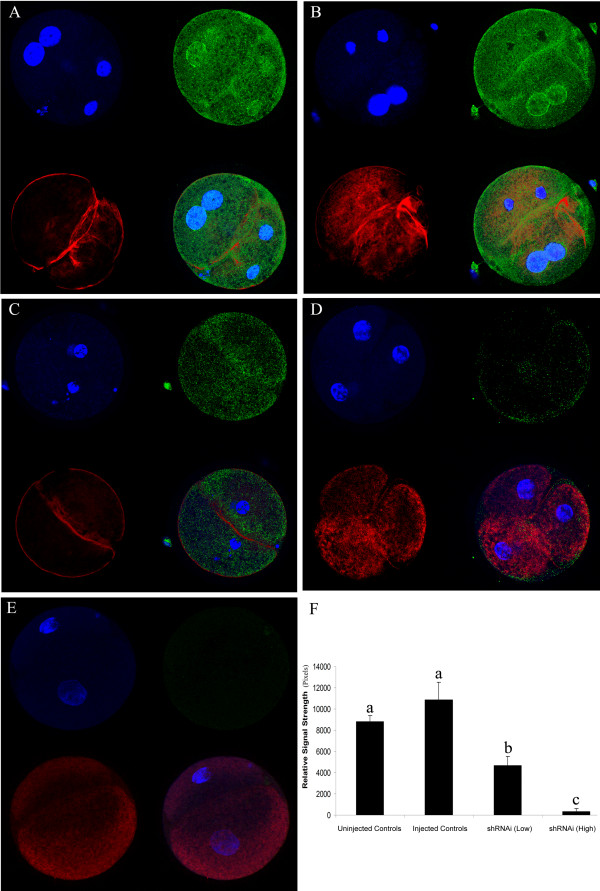
p66Shc protein levels following microinjection of p66 shRNA interfering molecules. The distribution of p66Shc in early bovine embryos was assessed (A, B, C and D). Green, red and blue colors in each representative photomicrograph indicate positive staining for the respective primary antibody: p66Shc (FITC), F-actin (Rhodamine phalloidin), and nuclei (DAPI) respectively. Panels A and B represent Uninjected and Injected (Vehicle) controls respectively. Panel C (shRNAi low dose = ~12,000 molecules) and Panel D (shRNA high dose = ~24,000 molecules) display a marked reduction in p66 fluorescence. Panel E represent the no primary antibody controls. Scion Image analysis resulted in the quantification of FITC immunofluorescence (p66Shc) across different groups (F). Relative signal strengths are presented as the mean ± S.E.M. representative of three independent replicates. Bars with different letters represent significant differences in relative signal strength between treatment groups (P ≤ 0.05).